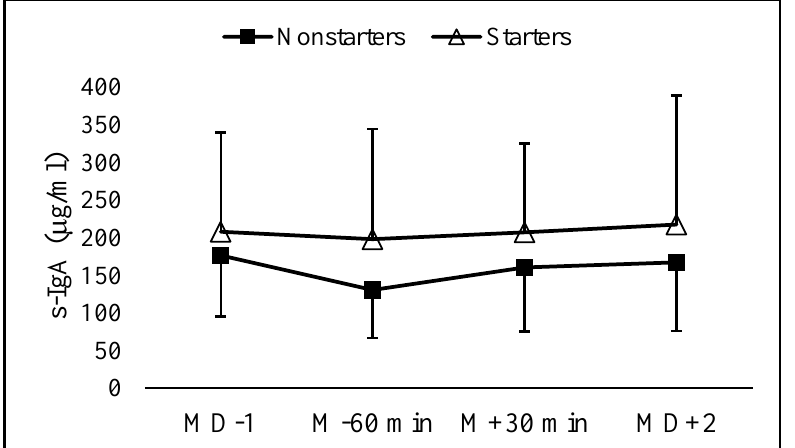
Figure 1. Mean and SD values of s-IgA the day before the match (MD − 1), 60-min before kick-off (M − 60 min), 30-min post-match (M + 30 min), and 48-h post-match (MD + 2).